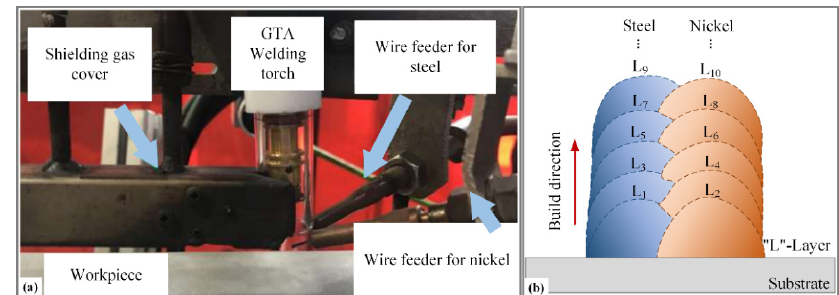
Figure 18. ( a ) Schematic of WAAM system, ( b ) Deposition path patterns [82].